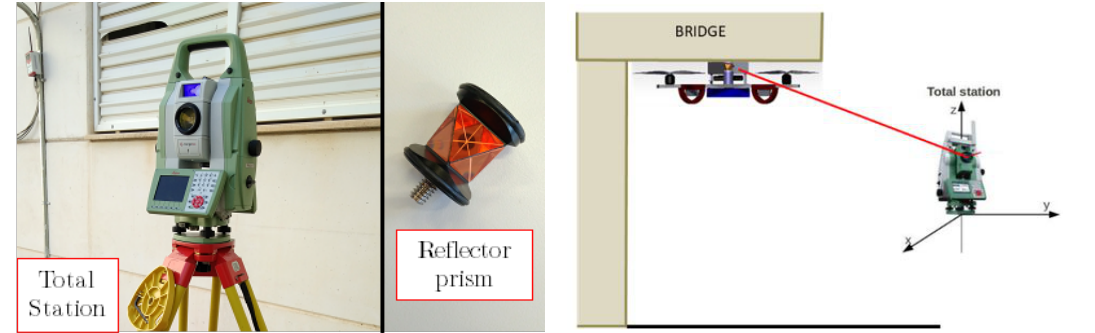
Figure 6. Total station and 360 ◦ mini-prism. ( Left ): actual laser system and the reflector mini-prism 360. ( Right ): scheme of the utilization of the laser tracker to obtain the UAV